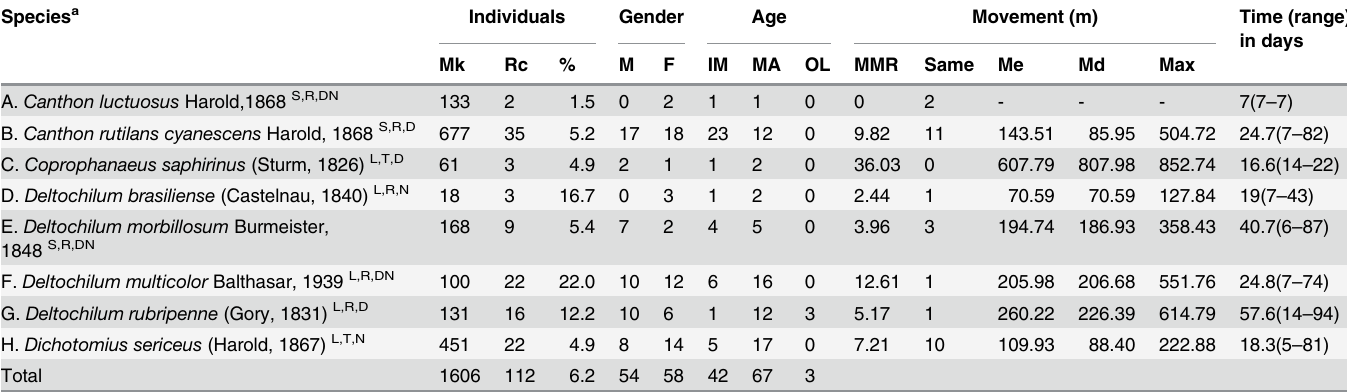
Table 1. Number of marked and recaptured individuals by gender and age categories, with movement values and time between recaptures for Scarabaeinae species. Species